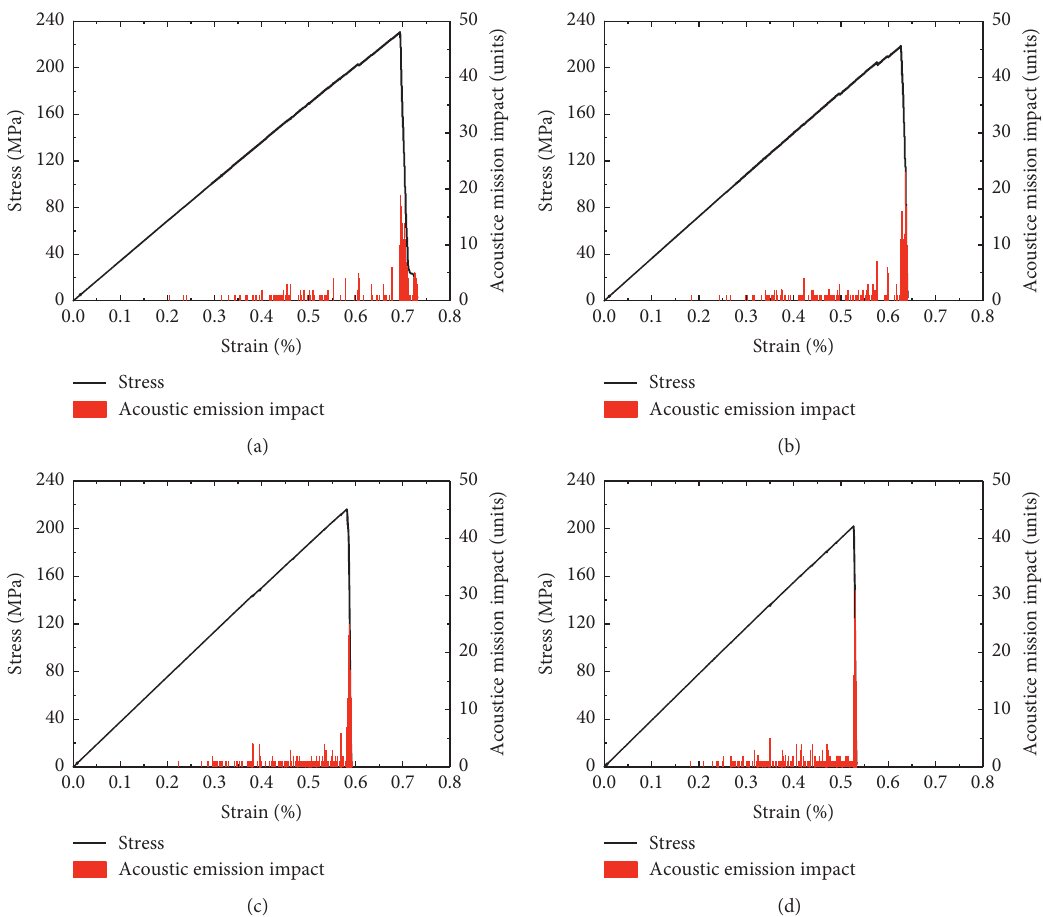
Figure 7: Stress-strain-acoustic emission characteristic curves of rock specimens with different values of K . (a) K � 1.0, (b) k � 1.5, (c) k � 2.0, (d) k � 2.5.